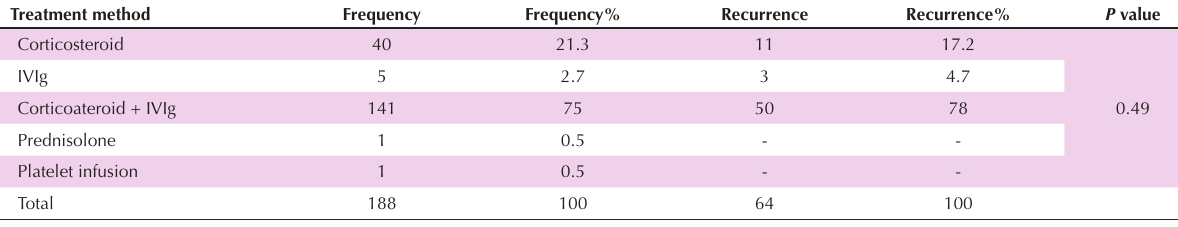
Table 3. Recurrence rate in children with ITP based on different therapeutic methods Treatment method